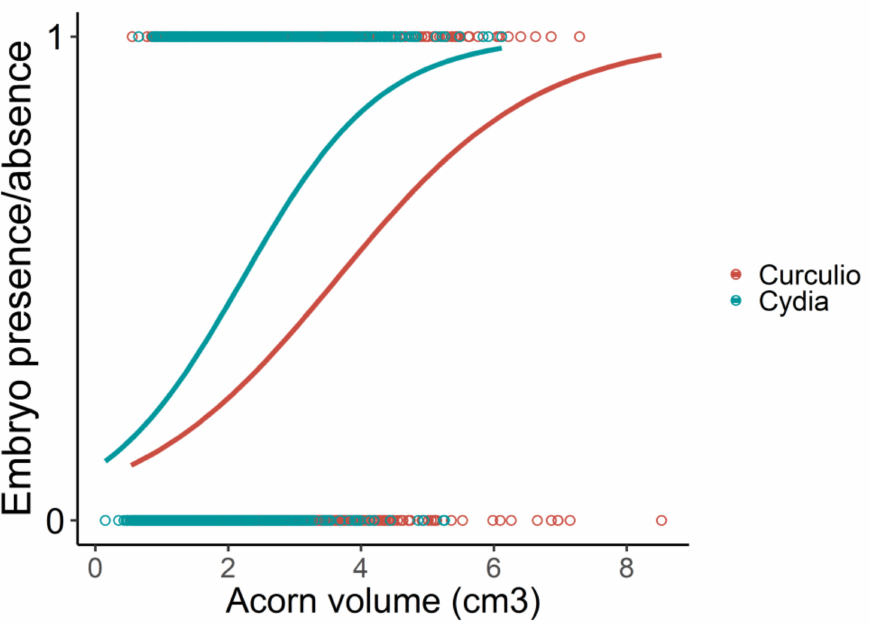
Figure 5. Relationship between acorn volume and embryo survival in acorns infested by Curculio and Cydia . The x -axis represents the acorn volume in cm 3 . The y -axis depicts embryo survival: (0–embryo killed. 1–embryo not killed). Red dots correspond to Curculio acorns and blue ones to those infested by Cydia .